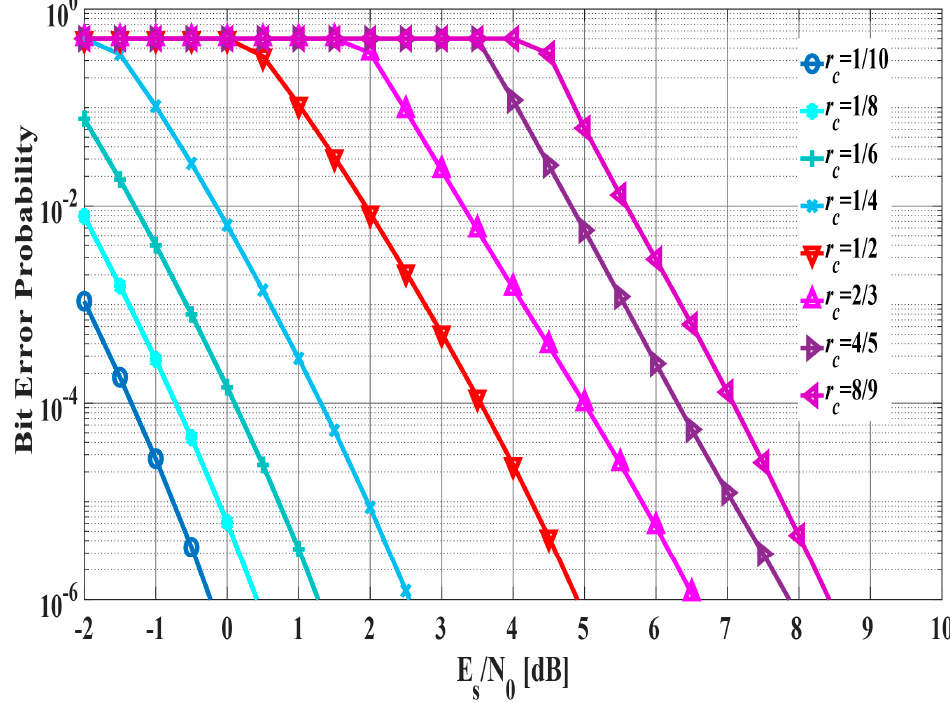
Figure 9. Bit error probability in each coding rate.